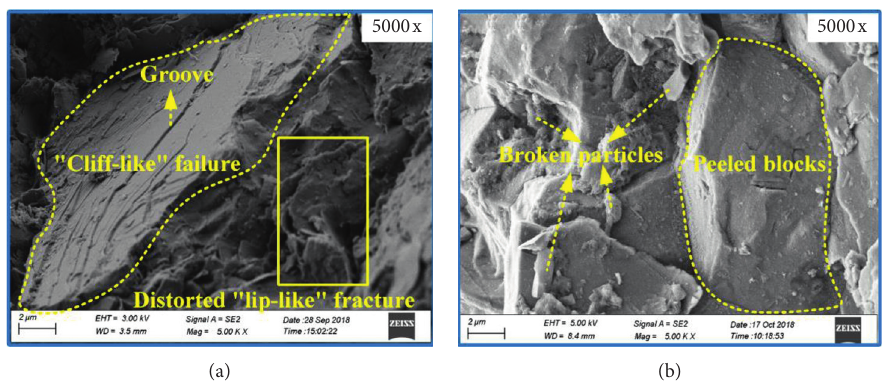
Figure 6: Typical SEM scanning images of the aggregate sections. (a) AWJ impact; (b) PWJ impact.